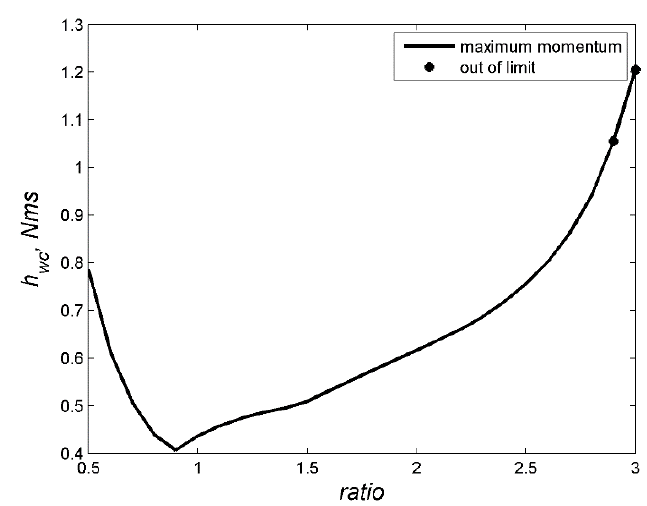
Figure 9. Maximum angular momentum with respect to inertial moment of the target.